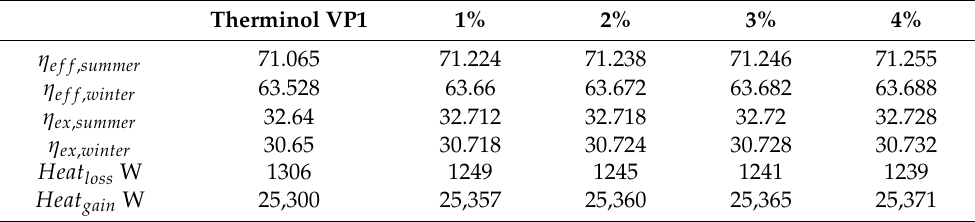
Figure 14. Exergy efficiency of the base fluid and HNFs for sunny and winter days in Budapest. Table 7. Major found results.